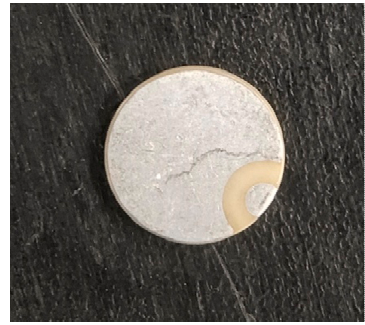
Figure 18. Picture of PZT–5A with the centre frequency of 350 kHz.